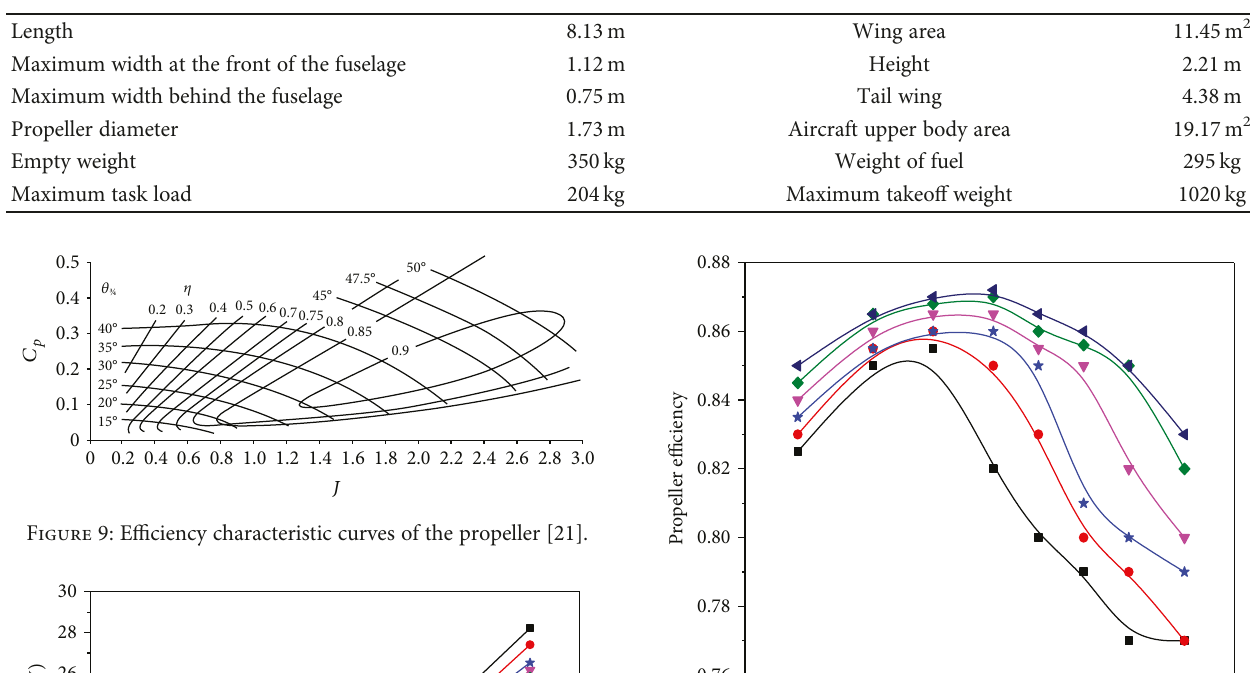
Table 3: The main parameters of UAV.